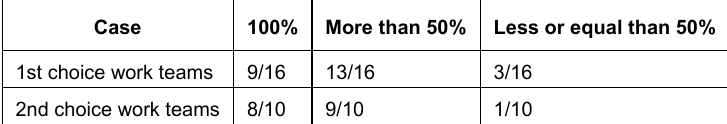
Table 8. Correspondence percentages for work teams using the Apriori algorithm